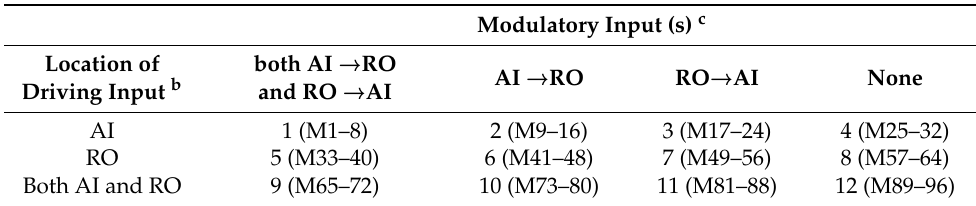
Table 1. Families designated according to the location of the driving input and modulatory inputs between AI and RO a in the DCM analysis.